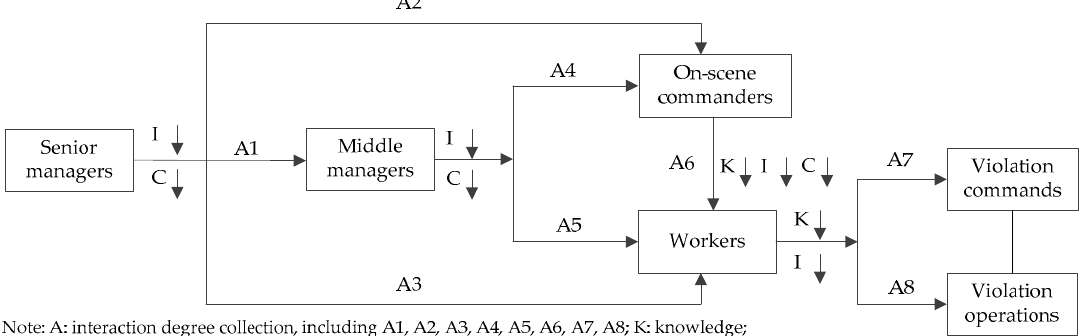
Figure 3. The interaction of potential human risk factors on the different functional levels’ personnel.